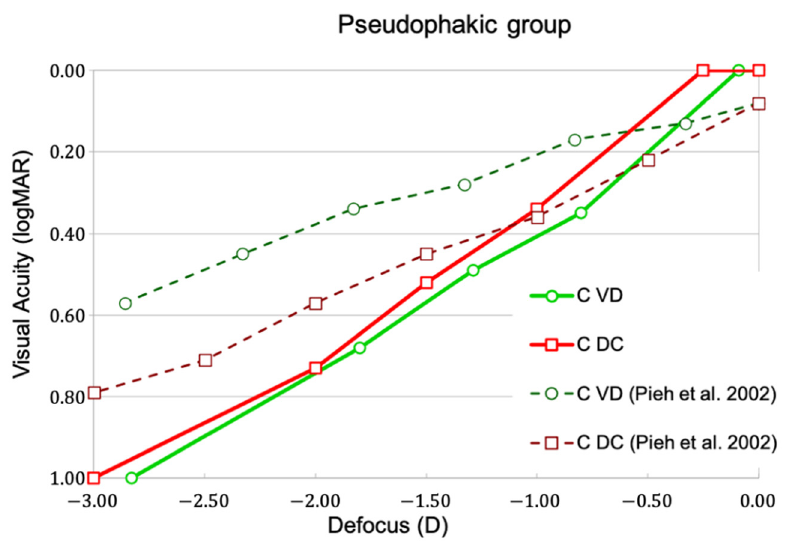
Figure 5. The corrected VA results that were obtained with the VD and DC methods for the pseu- dophakic group of this study (C VD, C DC) and those that were obtained by Pieh et al.[9] after corrections for minus lenses and the starting position of the chart (data extracted from figure 2 of Ref. 9 and adapted to this figure for the sake of